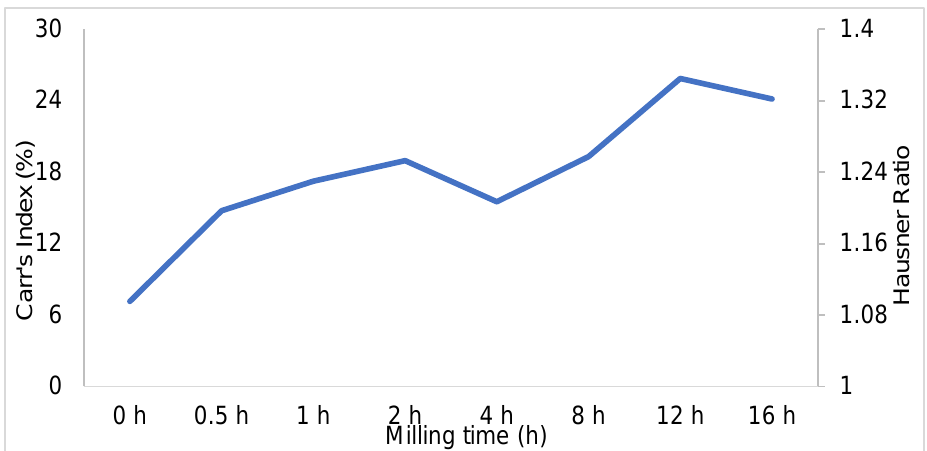
Figure 17. Reposed powder, showing GNPs, 0, 4 and 16 h milled alloy from ( a , c , e , g ) experimental work and ( b , d , f ) DEM simulation.